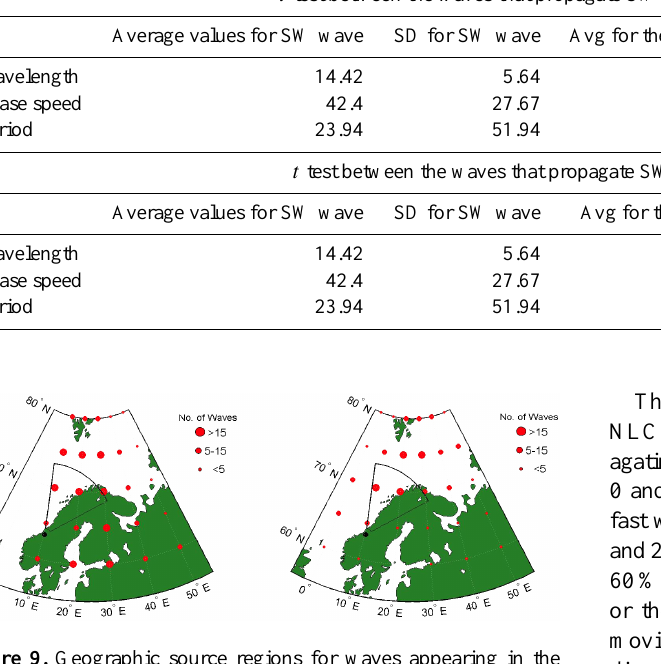
Figure 9. Geographic source regions for waves appearing in the FOV of the camera at NLC altitudes. The left panel shows the start- ing location of waves that have propagated upward from 5km and entered the FOV. The right panel shows the location of waves orig- inating at 60km that enter the FOV. For the grid points left blank there are no waves that enter the FOV of camera at NLC